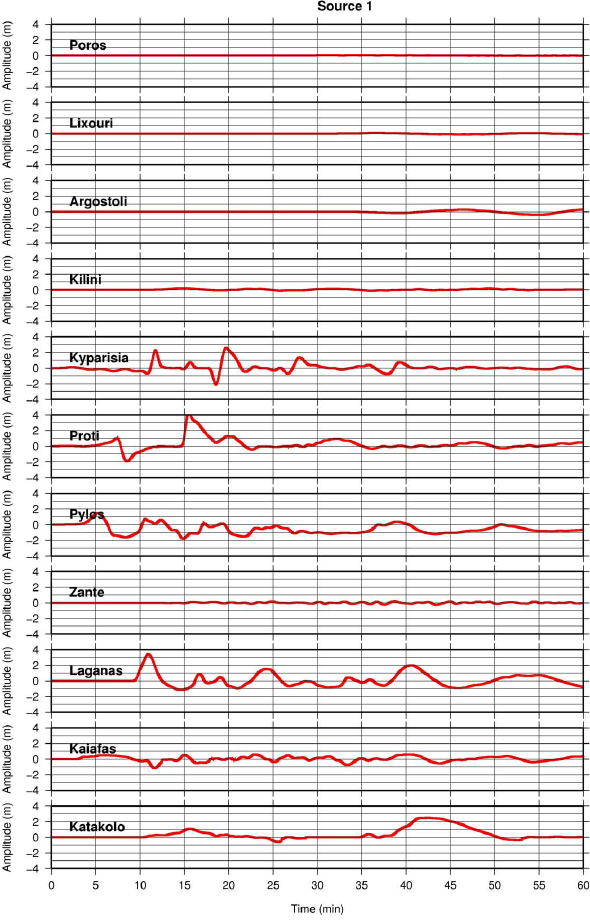
Fig. 5. Calculated mareograms at the locations shown in Fig. 4, for source 1 (Filiatra